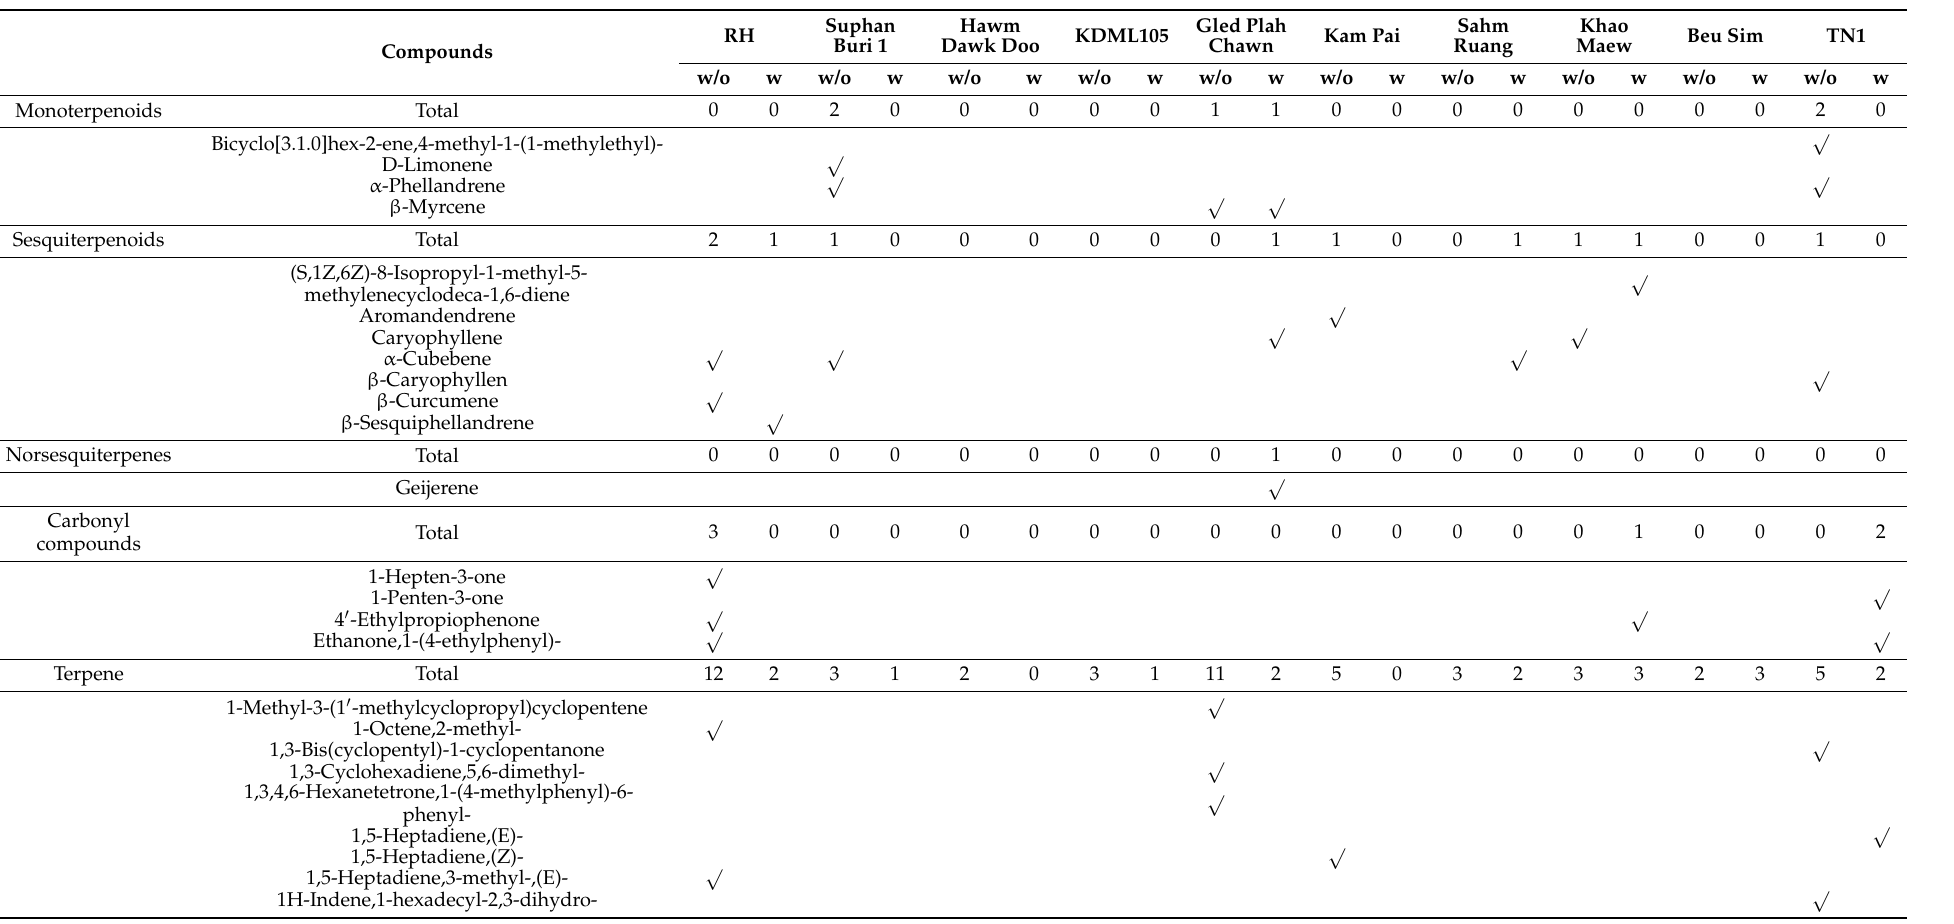
Table 6. Compounds identified in volatiles from 10 varieties of rice plants with (w) and without (w/o) BPH infestation. Compounds